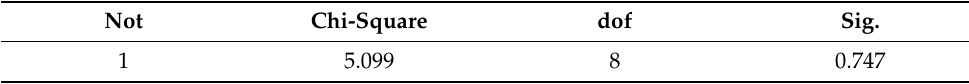
Table A8. Test of Hosmer and